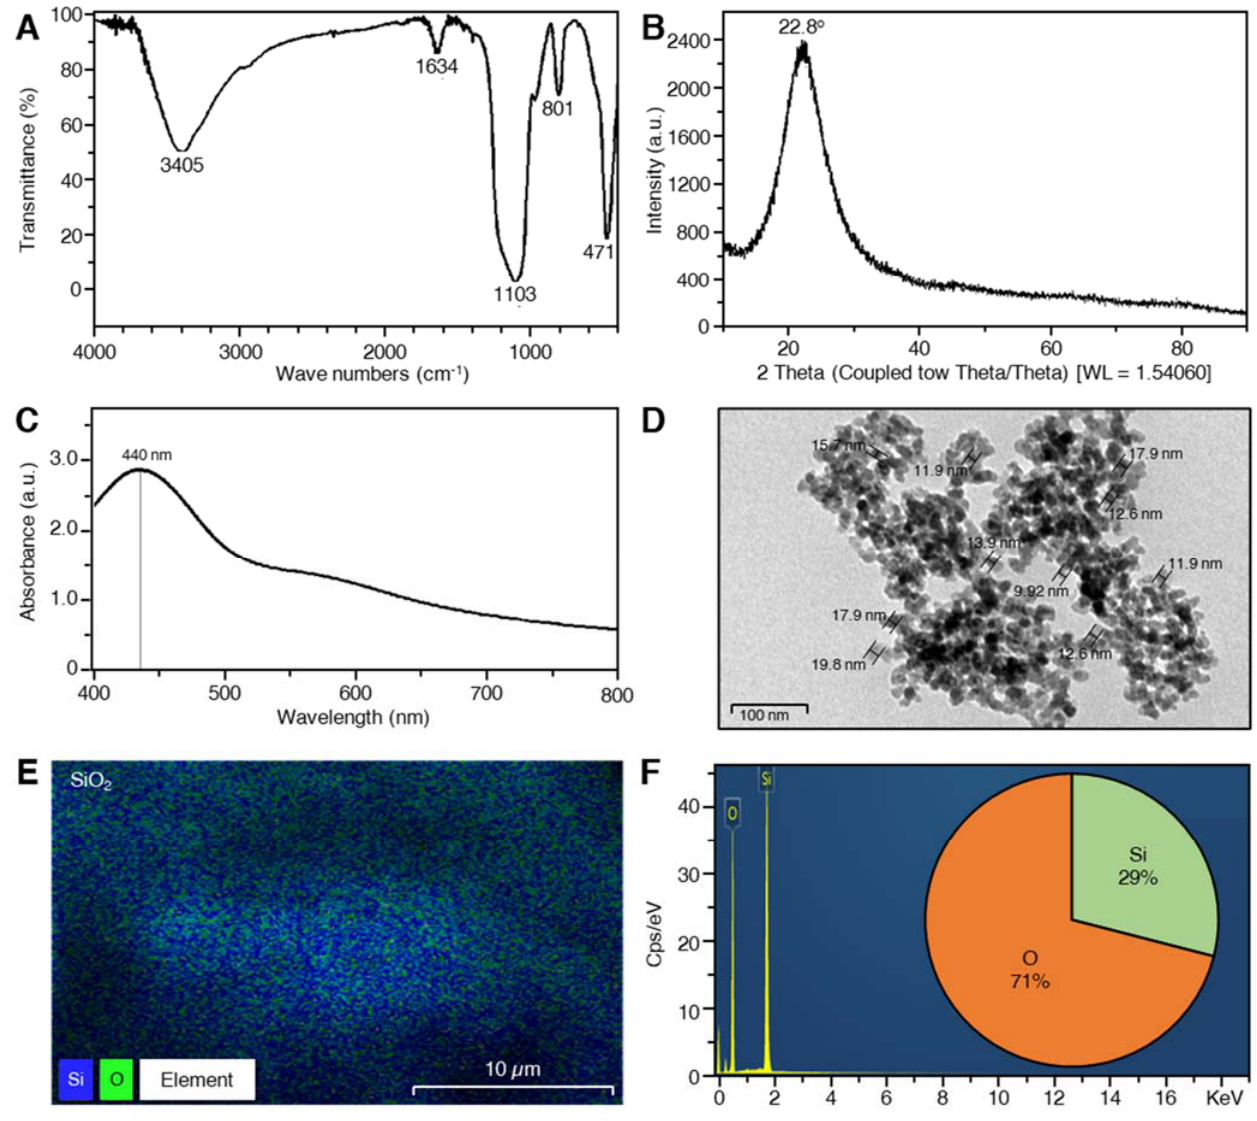
Figure 1. Structural and compositional characterization of silicon dioxide nanoparticles (SiO 2 NPs). ( A ) FTIR spectrum, ( B ) X-ray diffraction patterns, ( C ) UV-Vis spectrum, ( D ) Bright-field TEM image, ( E ) energy-dispersive X-ray spectroscopy (EDS) elemental mapping of SiO 2 , and ( F ) Energy dispersion spectrum (EDS) and its associated percentage of each element.